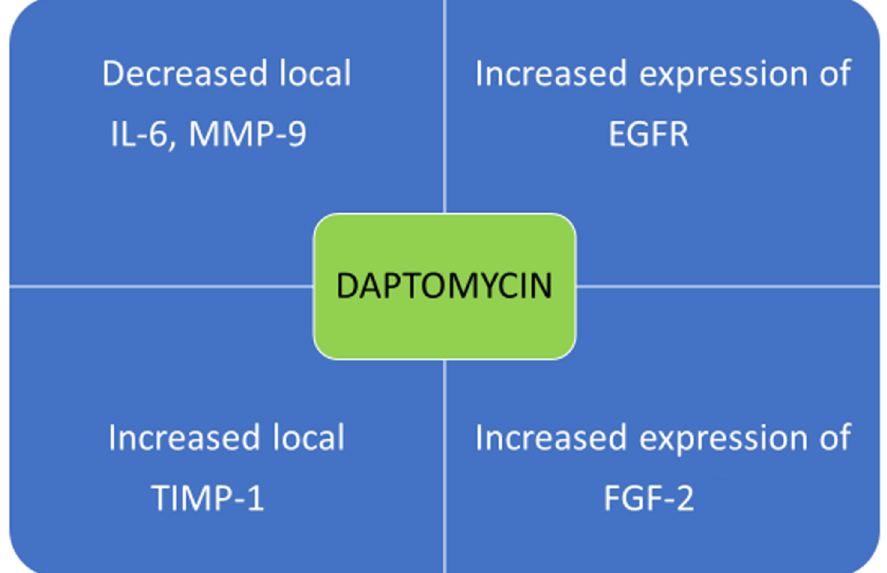
Figure 1. The possible immunomodulatory effects of daptomycin promoting cutaneous wound healing. Decreased local IL-6, MMP-9, increased local TIMP-1 [42] increased expression of EGFR, increased expression of FGF-2 [38] EGFR: epidermal growth factor receptor FGF-2: fibroblast growth factor-2 IL-6: interleukin-6. MMP-9: matrix metalloproteinase-9 TIMP-1: metallopeptidase inhibitor.